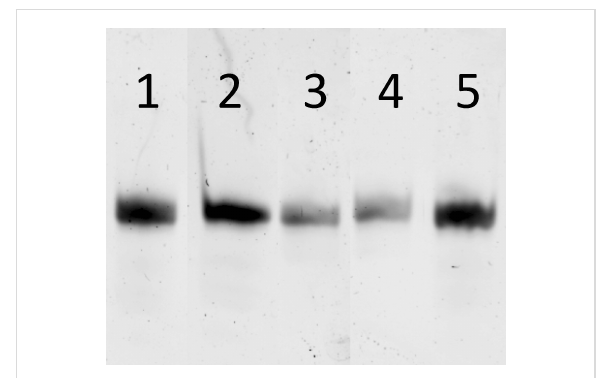
Figure 5: PAGE analyses of ODNs 30a – e . Lanes 1–5 are ODNs 30a – e ,